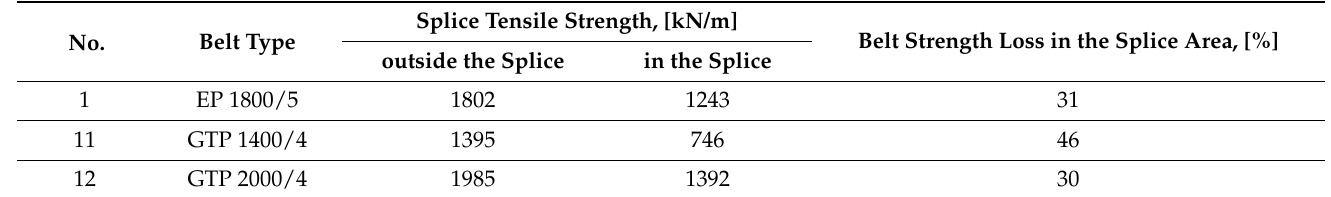
Table 3. Test results of splice strength.